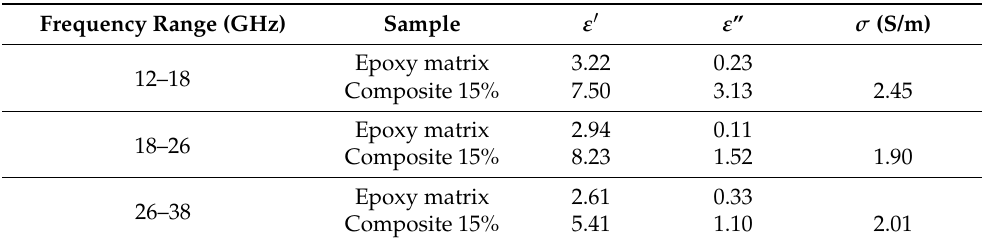
Table 1. Estimations of complex dielectric permittivity and microwave conductivity, averaged over the frequency ranges.